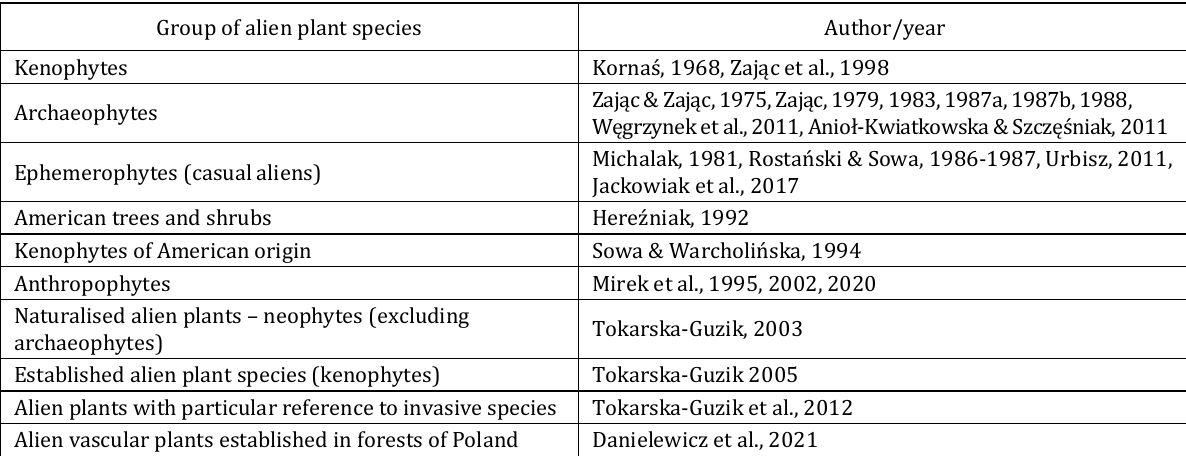
Table 1. Selected papers concerning lists of alien plant species (national and regional) in Poland (source: Tokarska-Guzik 2005, Tokarska-Guzik et al., 2014,